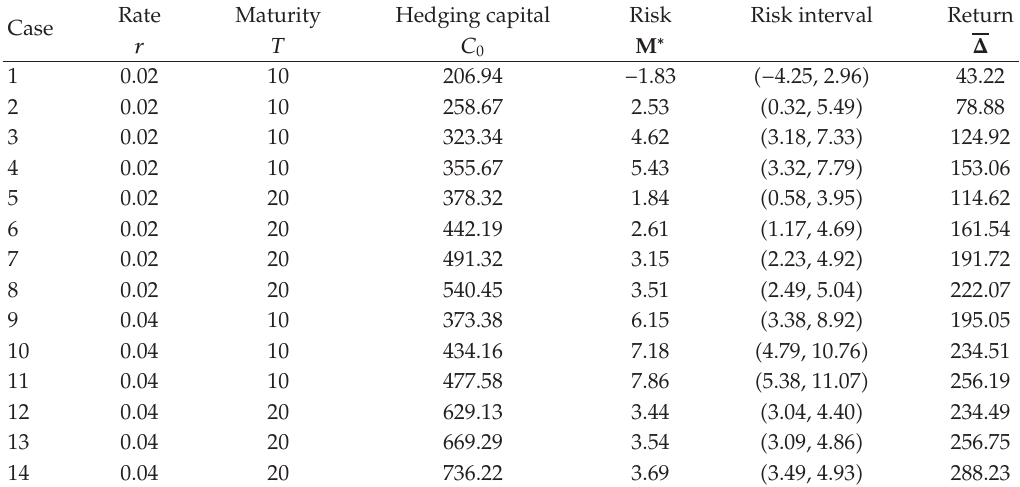
Table 1: Illustrative numerical results for two pure endowment contracts with